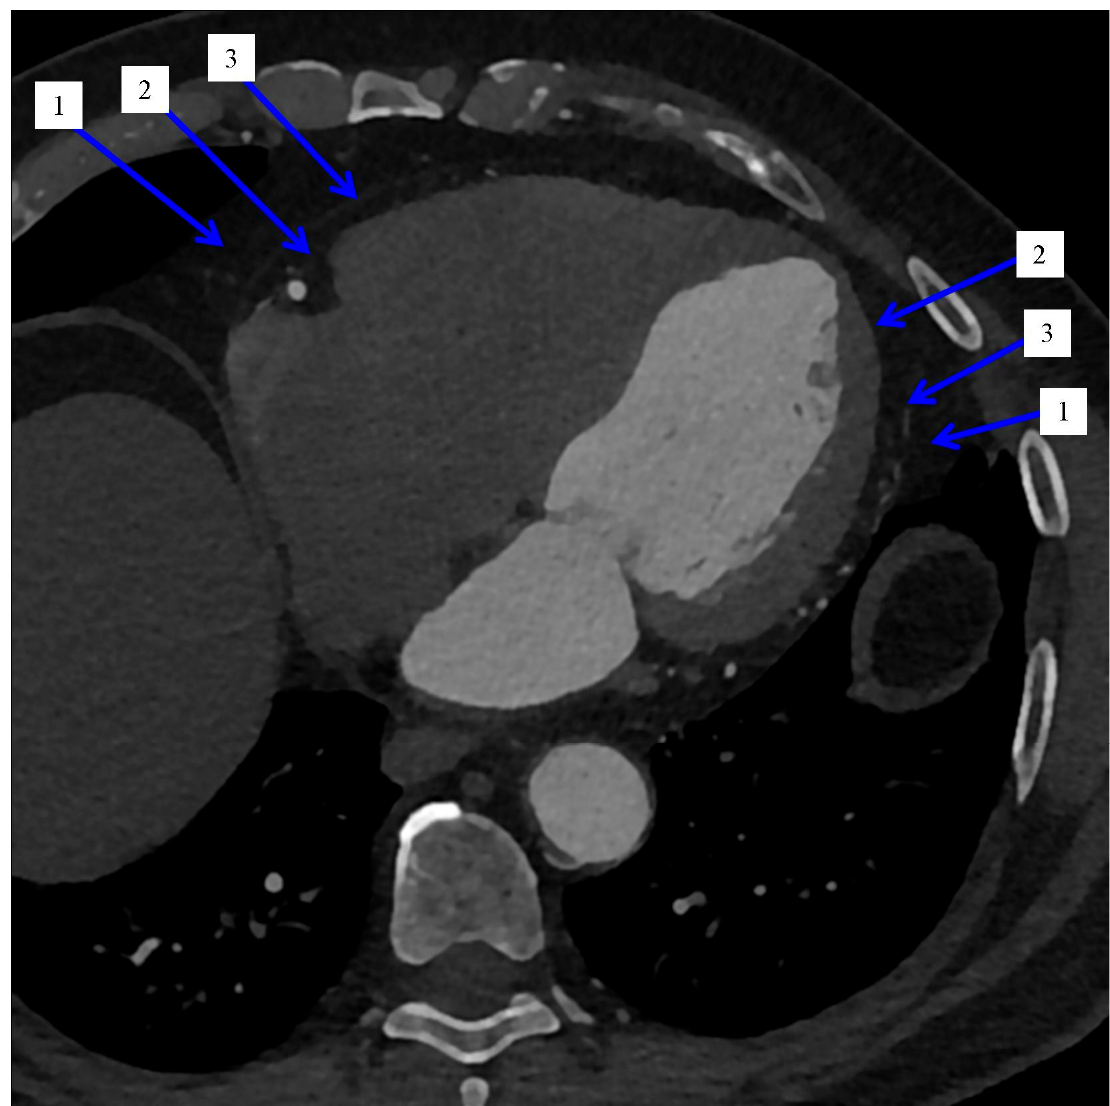
Figure 1. Cardiac computed tomography. Axial reconstruction. Blue arrows indicate: 1. Pericardial adipose tissue. 2. Epicardial adipose tissue. 3. Pericardium.